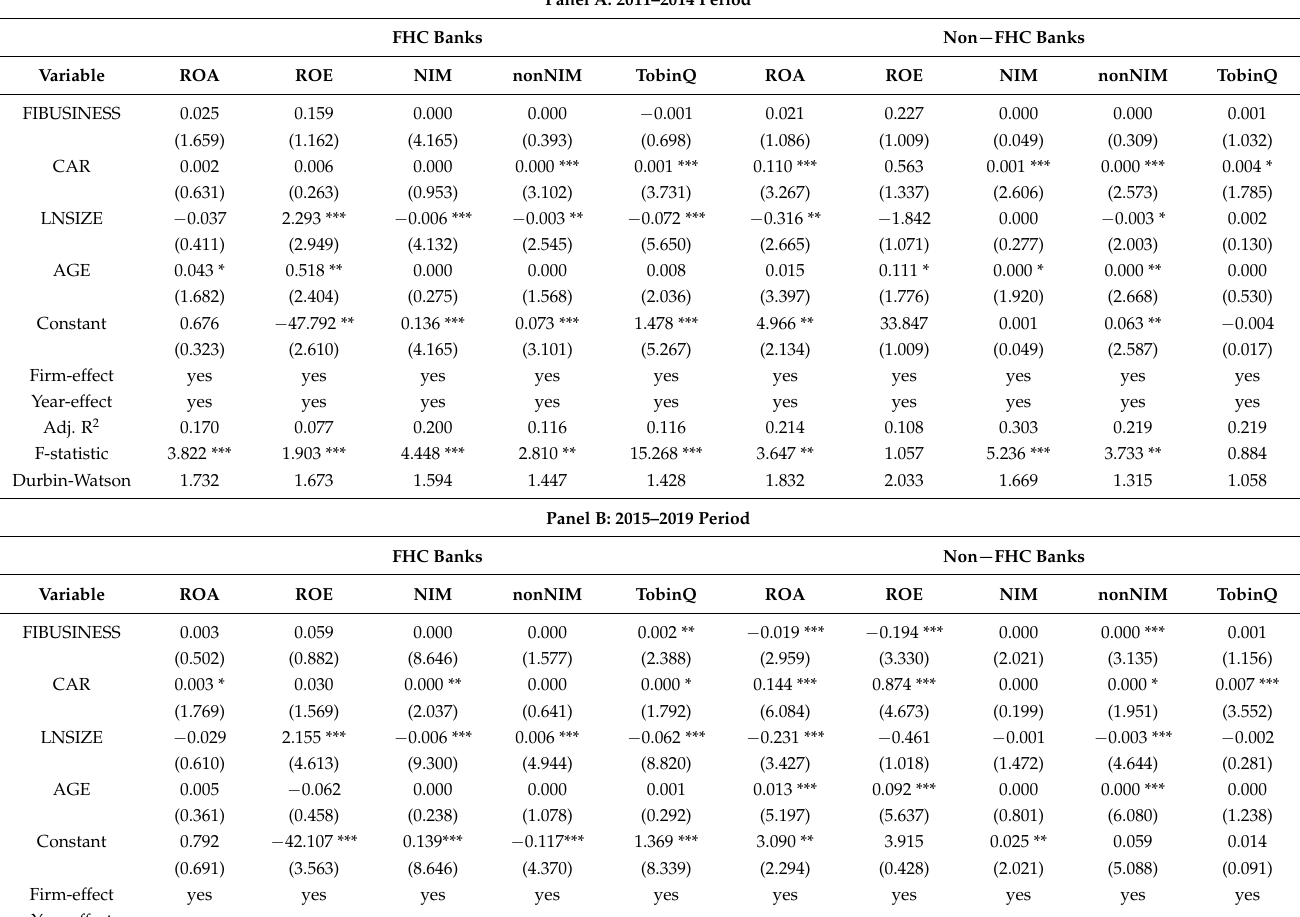
Table 9. The correlation between financial innovation and performance for FHC and non-FHC banks. Panel A: 2011–2014